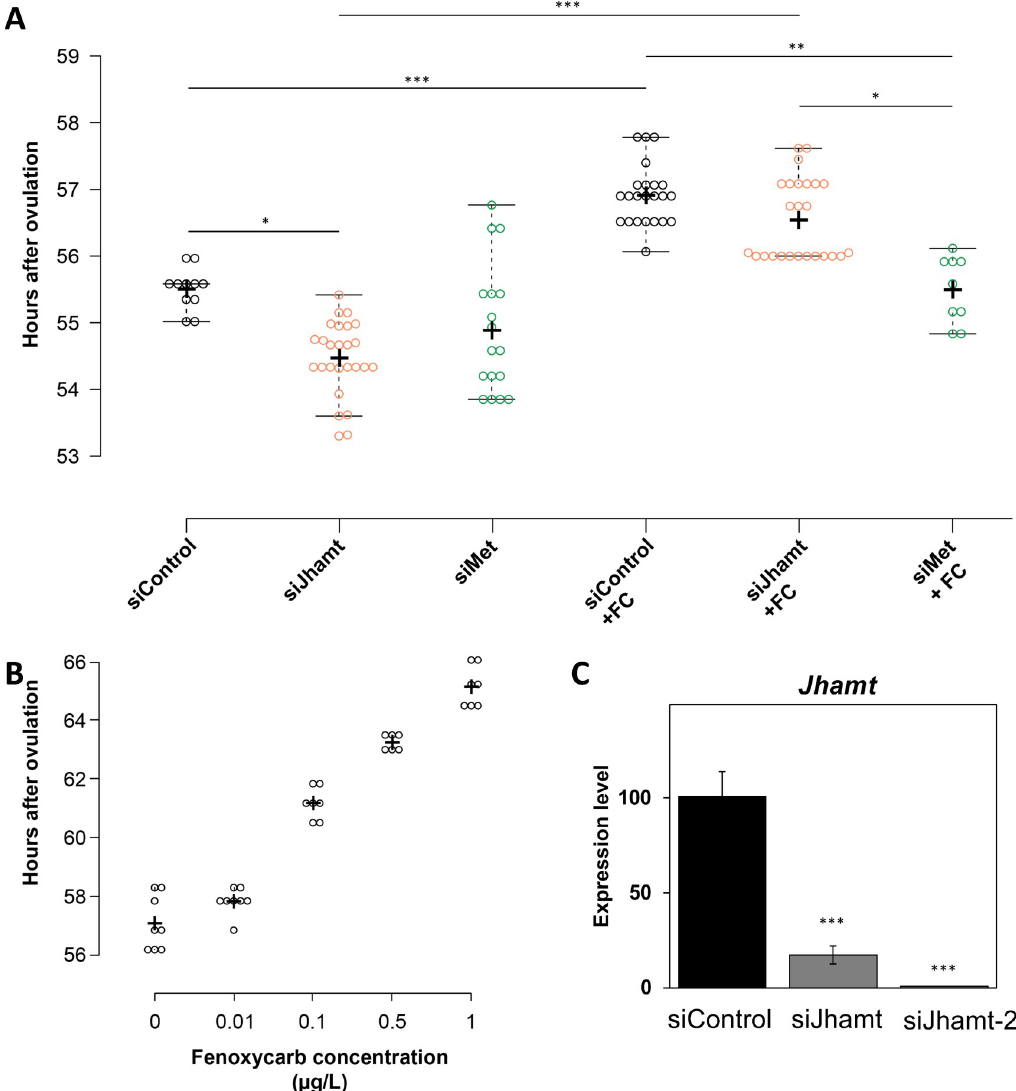
Fig 3. Jhamt knockdown shortens Daphnia magna embryonic period. (A) Embryonic periods (hours after ovulation, or hao) of siControl, siJhamt, and siMet embryos with or without fenoxycarb. � p < 0.05; �� p < 0.01; ��� p < 0.001 (Kruskal-Wallis followed by Dunn post-hoc test; p-values adjusted using the Benjamini-Hochberg procedure). (B) Embryonic period of embryos exposed to different concentrations of fenoxycarb. (C) Expression levels of Jhamt in 24 h embryos injected with siControl and siJhamt as measured by qRT-PCR. Values are means. Error bars represent SD (N = 3). �� p < 0.01 (Student’s t